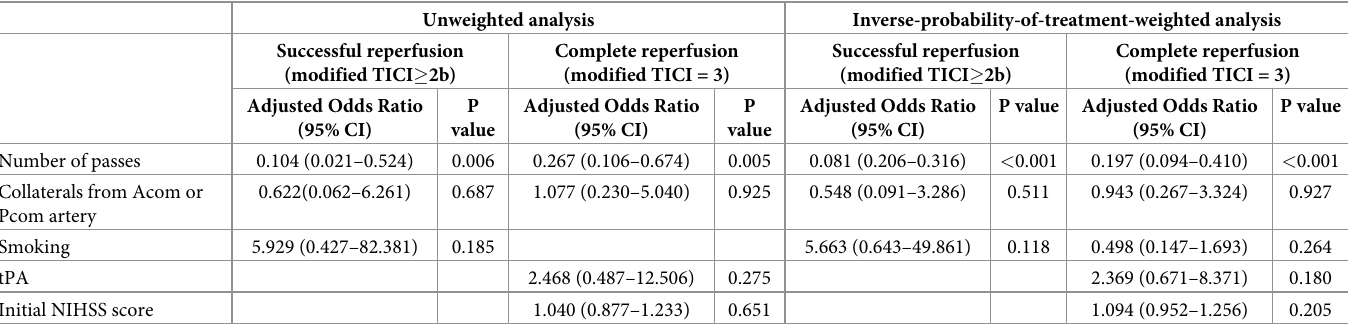
Table 5. Multivariable logistic regression analysis with dependent variables for successful reperfusion and complete reperfusion in the distal DAC group (n =